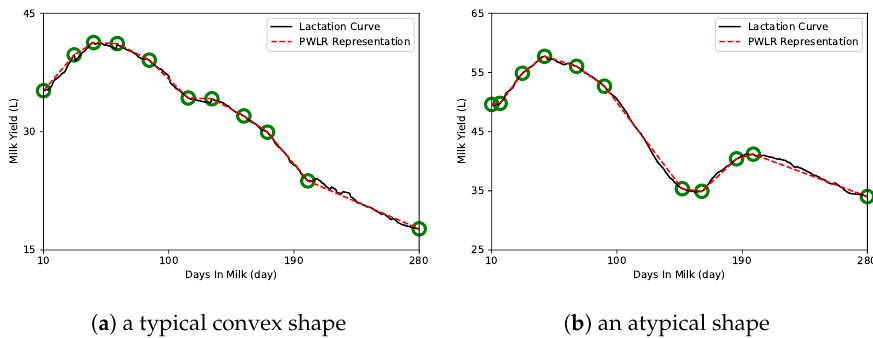
Figure 4. Approximation results using PWLR when p = 11 for the same LCs in Figure